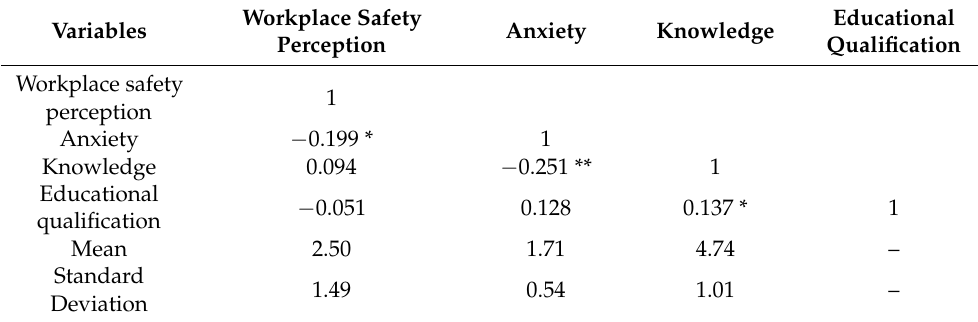
Table 2. Correlations, means, and standard deviations for the variables in this study.